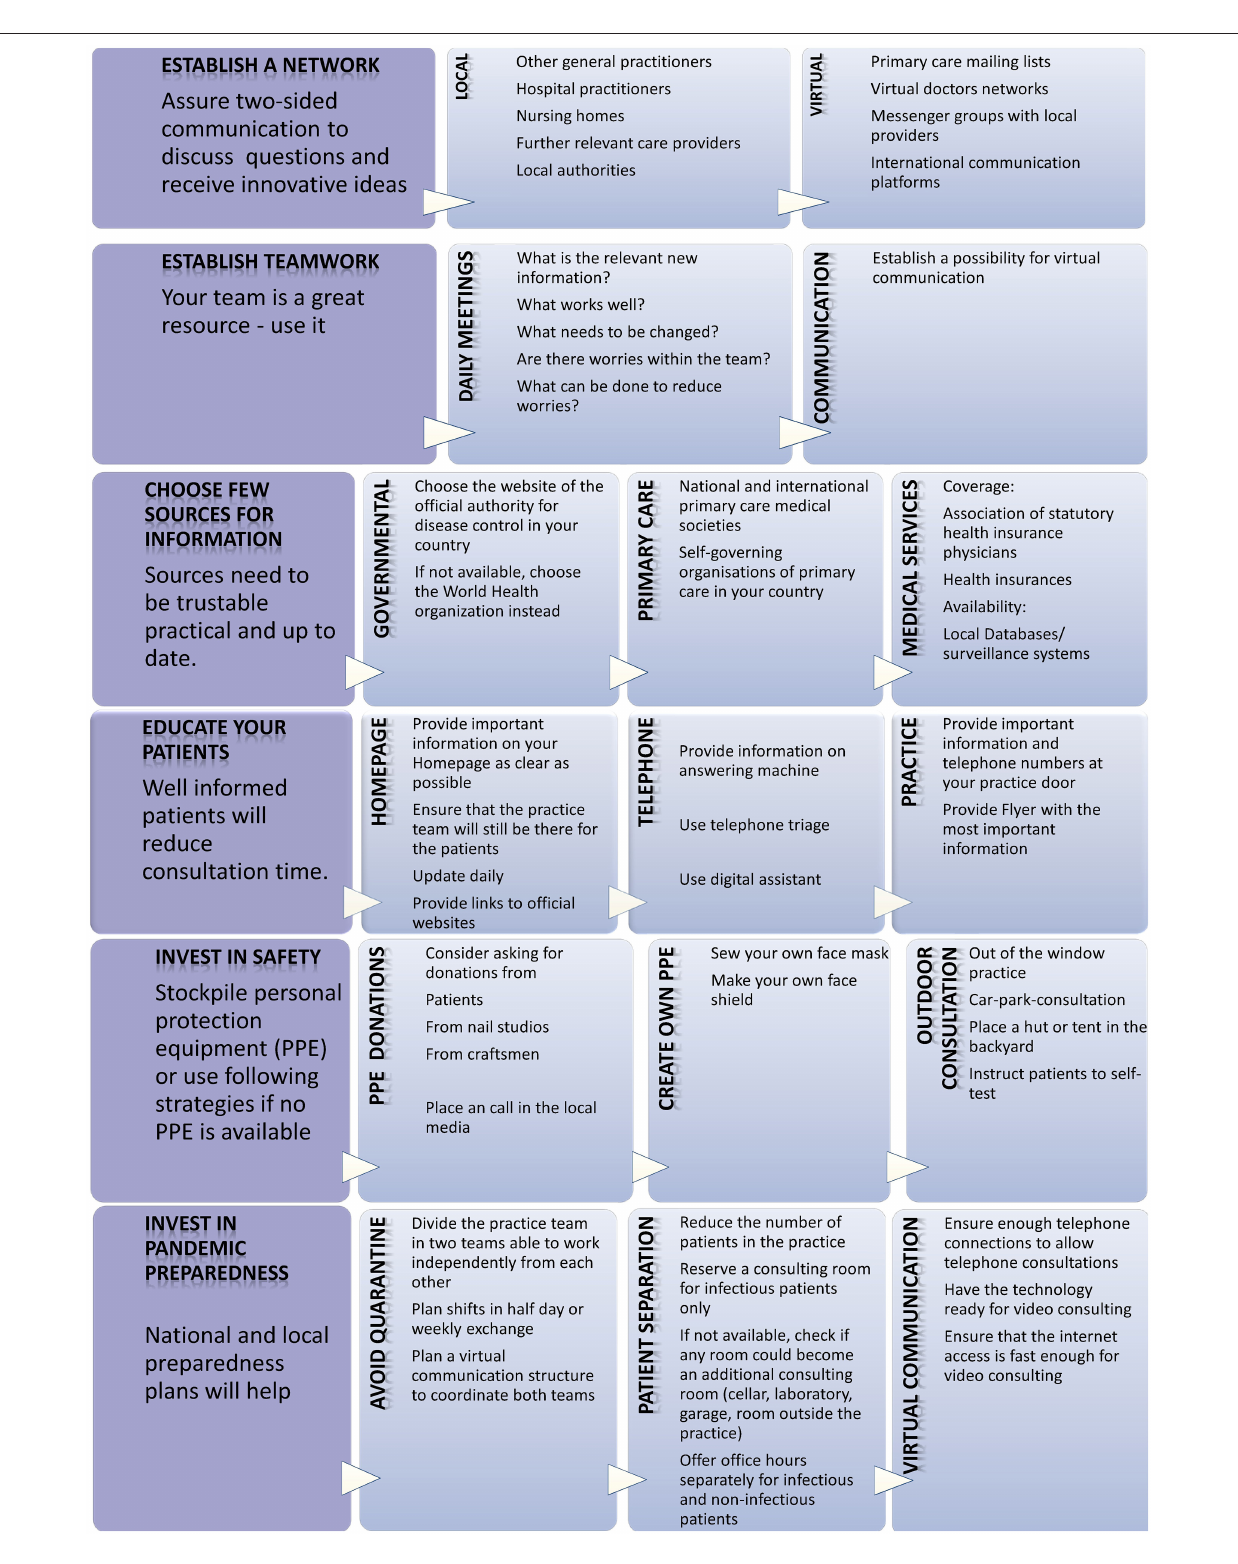
Frontiers in Medicine |